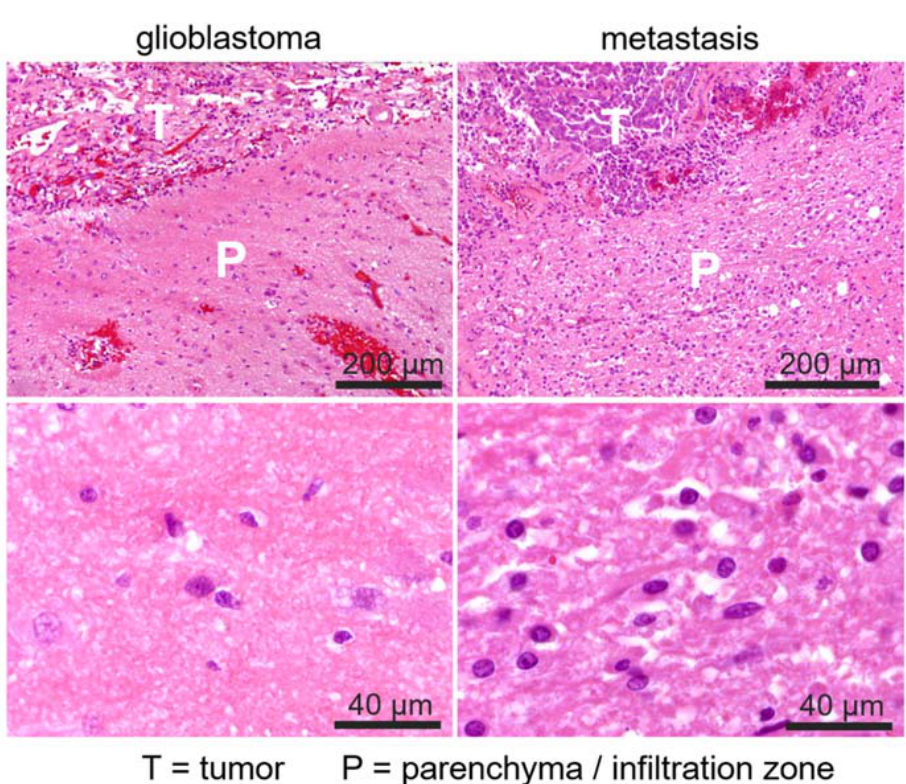
Figure 6. Example of histological sections in H&E staining in patients with IDHwt GBM ( left ) and metastasis of ovarian cancer ( right ). Images in the top row illustrate the immediate neighboring tumor (T) and adjacent parenchymal (P) areas in both samples. Microstructural loosening of the tissue in the surrounding white matter (P) appears prominently in the metastasis case, but is almost absent in glioblastoma, which is particularly visible in detailed images at higher magnification (400 × , bottom row), and was interpreted as a sign of increased vasogenic edematization. Magnification bars indicate 200 µ m ( top row ) and 40 µ m ( bottom row ), respectively.